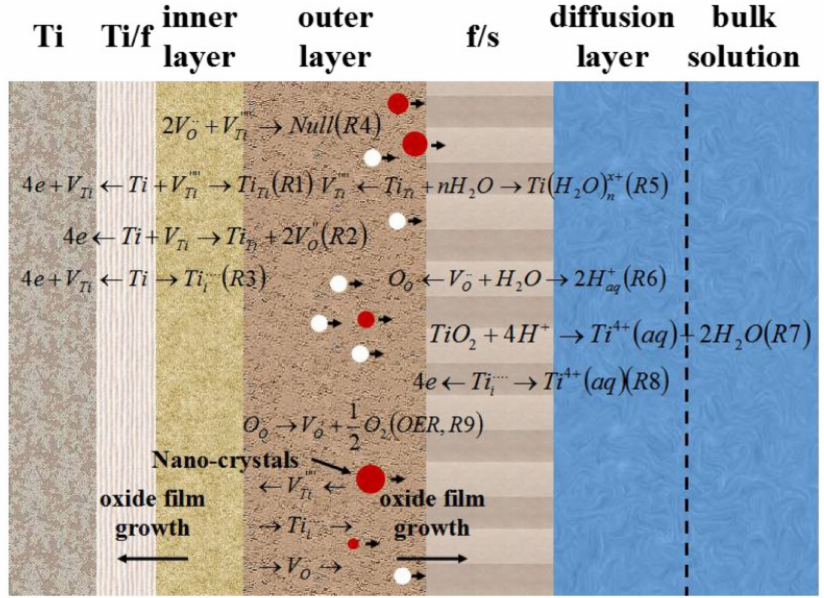
Figure 11. Schematic illustration of the growth process of oxide